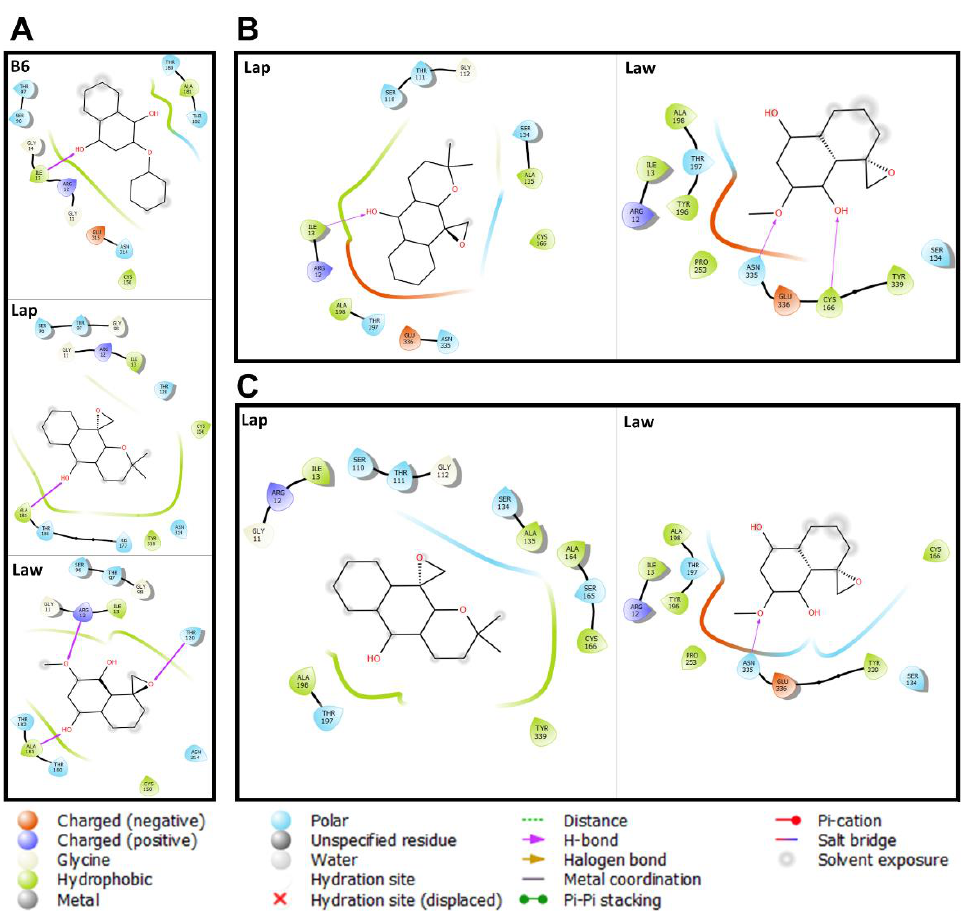
Figure 4. Molecular interaction of naphthoquinone derivatives with Leishmania spp. glyceraldehyde 3-phosphate dehydrogenase. Docking assays were performed with glyceraldehyde 3-phosphate dehydrogenase of T. brucei ( A ); L. ( L. ) amazonensis ( B ); and L. ( V. ) braziliensis ( C ). The 2D representation indicates the types of bonds that occur in glyceraldehyde 3-phosphate dehydrogenase with 2-phenoxy-1,4-naphthoquinone (B6), Epoxy- α -lapachone (2,2-dimethyl-3,4-dihydro- spiro[benzo[g]chromene-10,20-oxiran]-5(2H)-one-Lap), and Epoxymethyl-lawsone (2-Methyl-4H-spiro-[naphthalene- 1,20-oxiran]-4-one-Law).